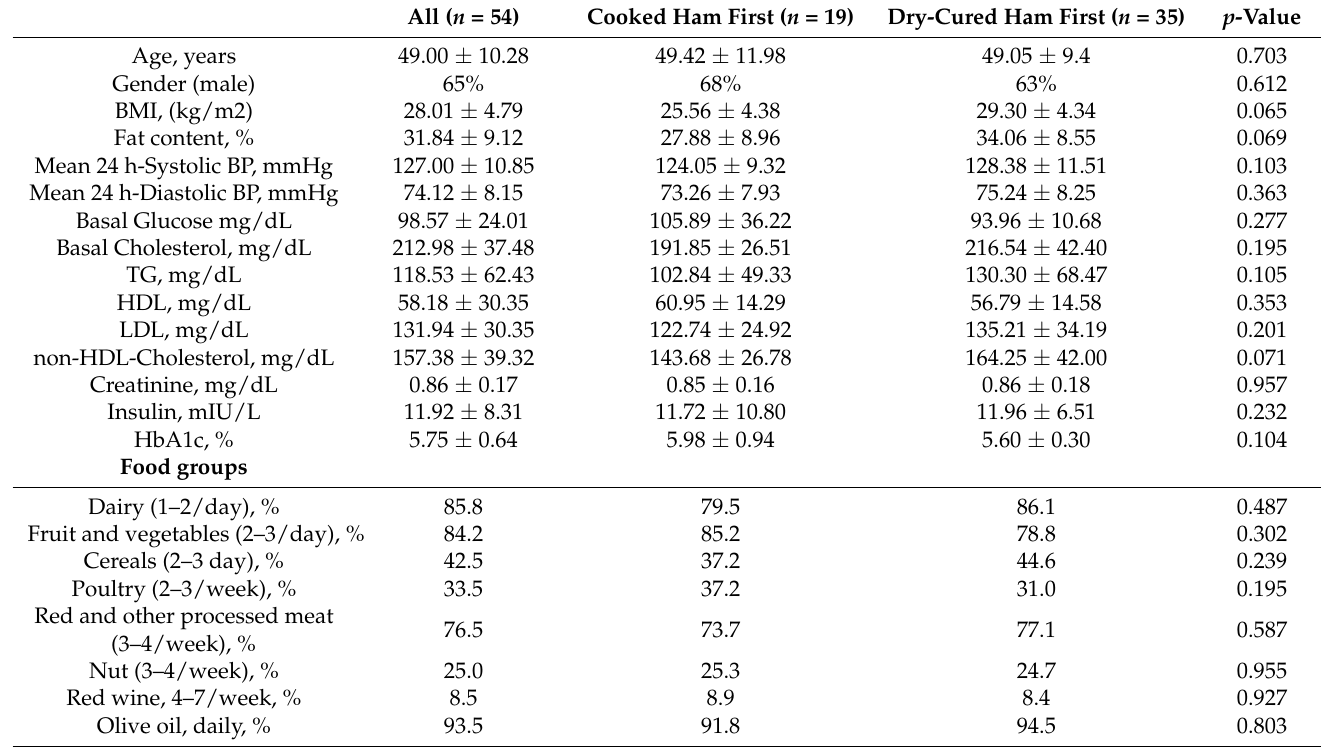
Table 3. Clinical characteristics of participants with normal-high BP expressed as